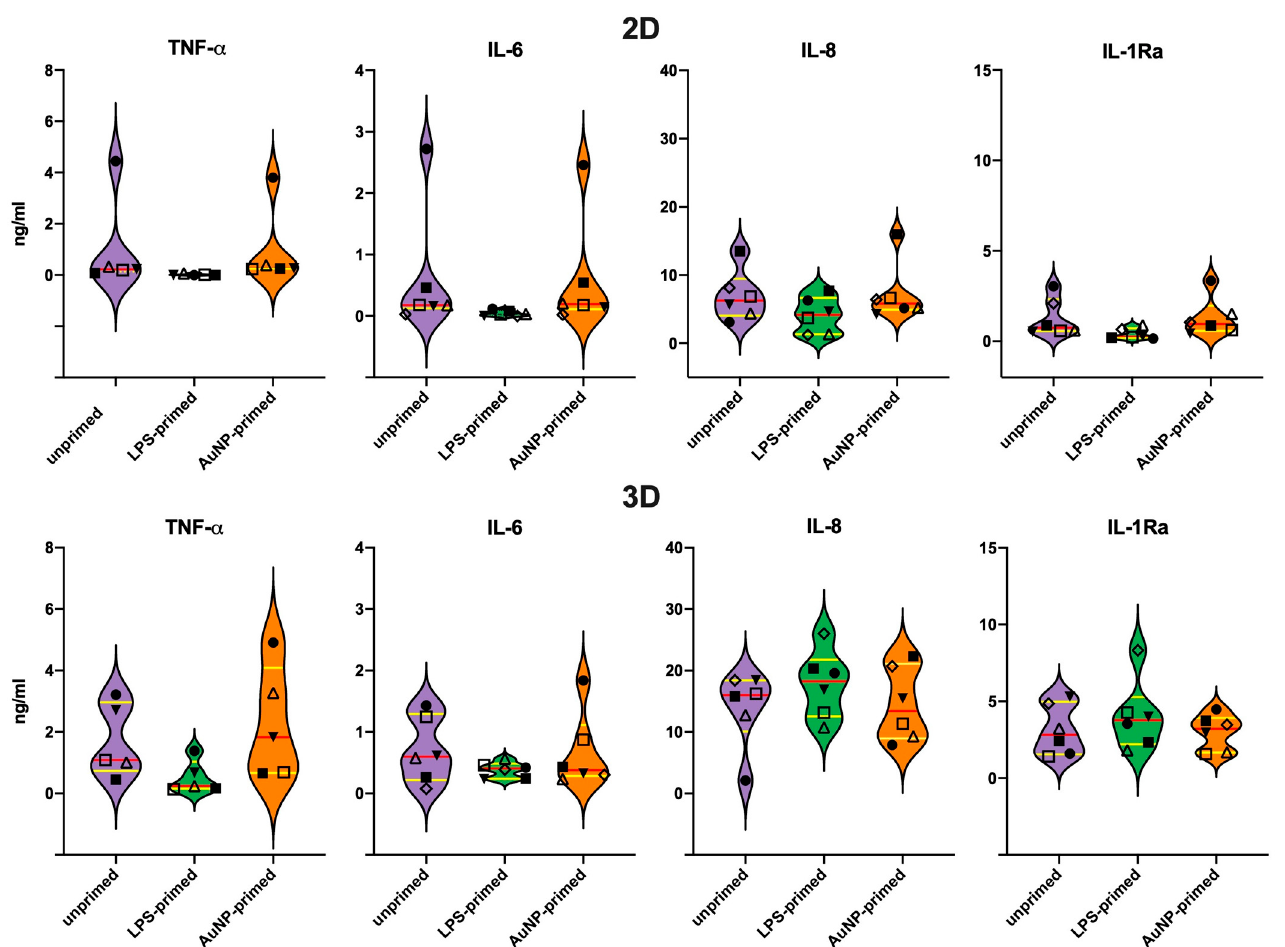
Figure 4. Secondary cytokine production by primed monocytes challenged with LPS in 2D vs. 3D culture. Production of the inflammatory cytokines TNF α and IL-6, the chemokine IL-8 and of the anti-inflammatory cytokine IL-1Ra by monocytes of six donors previously primed in vitro with culture medium alone (unprimed), LPS (LPS-primed) or AuNPs (AuNP-primed). After 24 h priming, cells were rested in culture for 6 days and then challenged with 10 ng/mL LPS for 24 h. Results obtained in 2D cultures are reported in the upper panels, while data from 3D cultures are reported in the lower panels. The violin plots represent the distribution of the individual donors’ values in each experimental condition. The red line indicates the median value, and the yellow lines the first and third quartiles. Individual donors are represented with different symbols: donor 1; (cid:4) donor 2; ∆ donor 3; (cid:72) donor 4; (cid:3) donor 5; • donor 6. Statistical significance was assessed with the paired (cid:51) one-tailed non-parametric Wilcoxon signed-rank test, and show significant differences ( p < 0.05) between unprimed and LPS-primed production of TNF α (2D and 3D), IL-6 (2D) and IL-1Ra (2D), while the differences between 2D and 3D were significant for IL-8 and